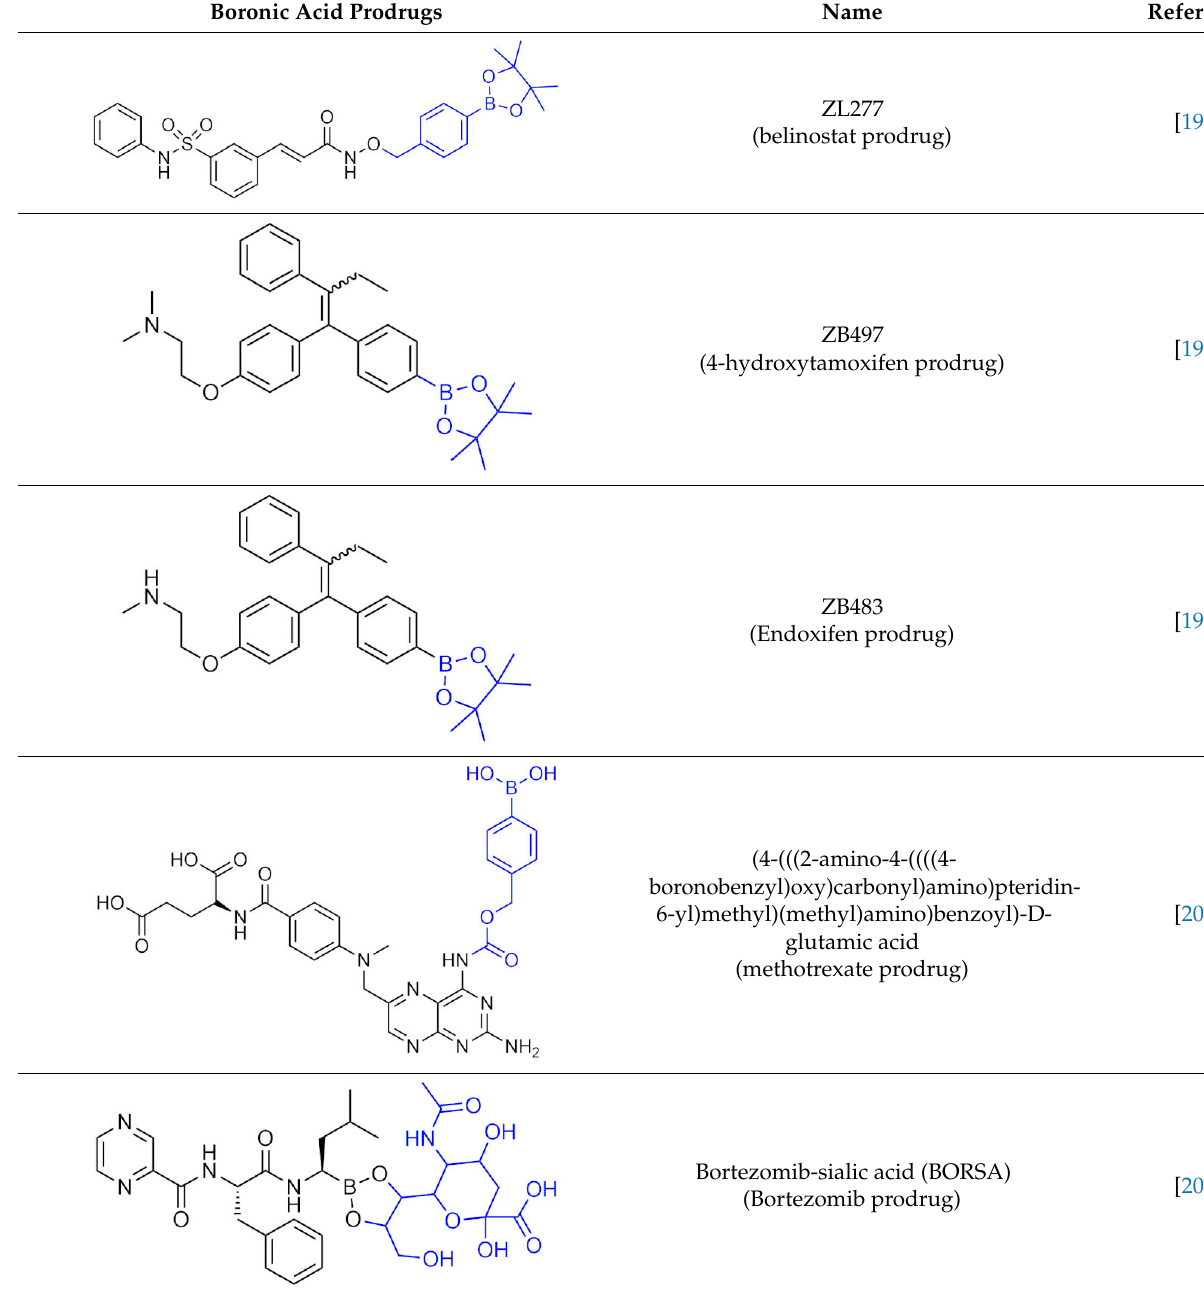
Table 7. Boronic acid prodrugs with the prodrug moiety in blue and the active drug in black. Boronic Acid